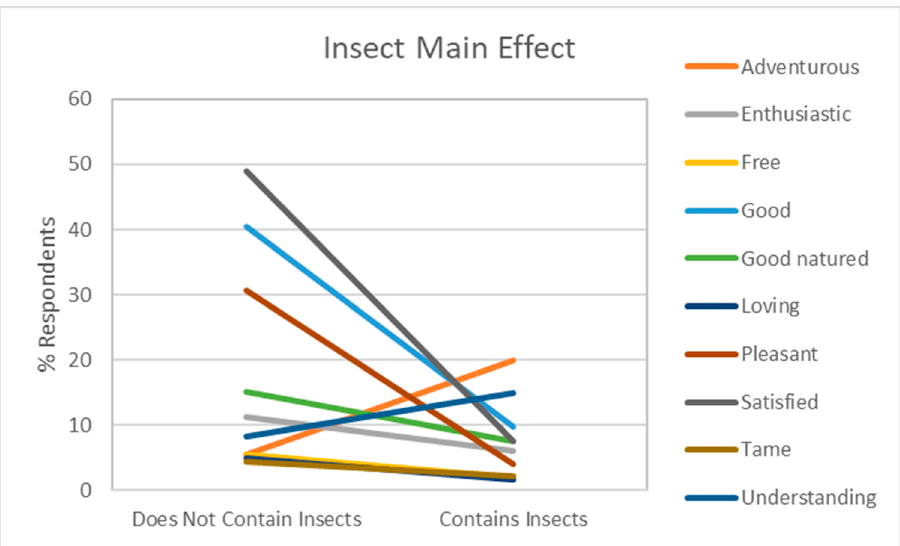
Figure 3. Effect of the Insect Presence Information on the emotional responses adventurous, enthu- siastic, free, good, good-natured, loving, pleasant, satisfied, tame, and understanding. The y-axis indicates the predicted mean rating of Liking and Willingness to Try, and the x-axis is the presence or absence of Insect Information.